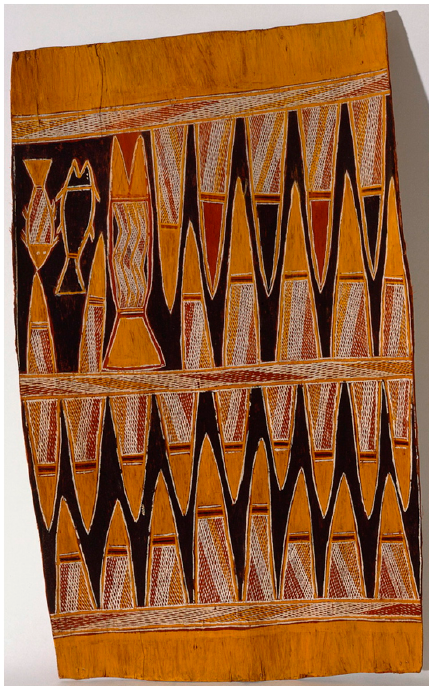
Figure 5. Binyinyuwuy , Djeritmingin Spirit -Woolen River , 72.4 cm × 44.5 cm, Natural pigments on bark, image courtesy Art Gallery of New South Wales, Gift of Dr. Stuart Scougall. © Estate of the artist licensed by Aboriginal Artists Agency Ltd.